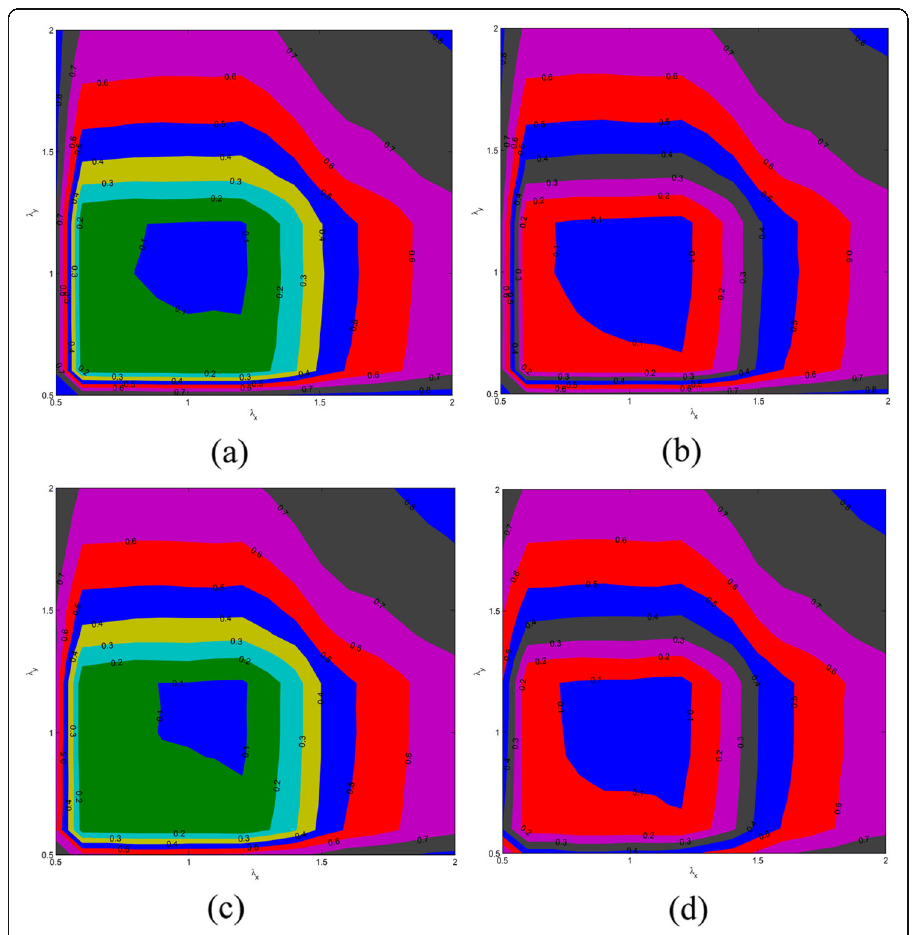
Fig. 9 Search values of different parameter combinations of λ x and λ y within a limited region: a 256 × 256, b 128 × 128, c 64 × 64, and d 32 ×